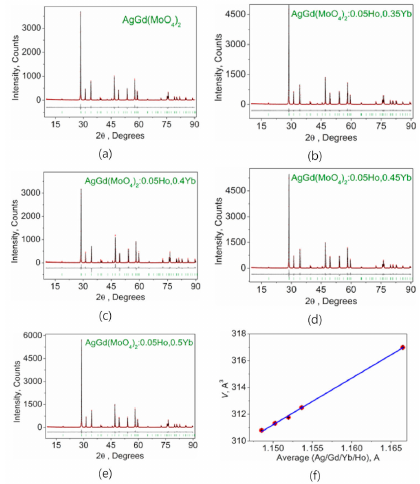
Figure 1. Di ff erence Rietveld plots of AgGd 1 − x − y Ho x Yb y (MoO 4 ) 2 : ( a ) x = 0, y = 0; ( b ) x = 0.05, y = 0.35; ( c ) x = 0.05, y = 0.4; ( d ) x = 0.05, y = 0.45; ( e ) x = 0.05, y = 0.5. ( f ) Cell volume per average ion radii